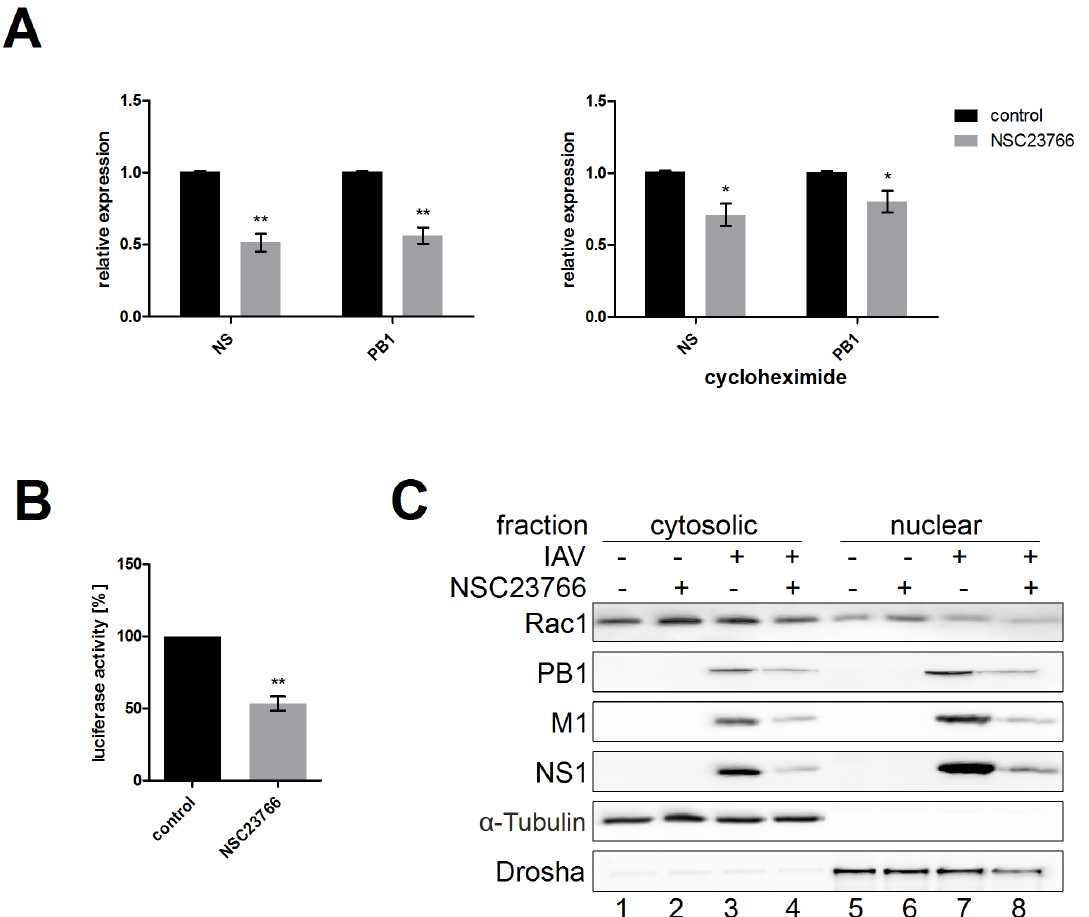
Figure 5. NSC23766 treatment results in reduced viral mRNA levels caused by impaired activity of the viral polymerase complex. (A) A549 cells were infected with A/Puerto-Rico/8/34 rec. (moi=5) and subsequently treated with NSC23766 (100 m M) 30 min post-infection. Six hours p.i., the RNA was isolated for qRT-PCR and the fold increase of ns and pb1 mRNA compared to uninfected cells was determined using the housekeeping gene gapdh as the internal standard. Treatment of cells with cycloheximide (10 m g/ml, right panel) was performed to inhibit de novo protein synthesis. (B) Viral polymerase activity was assayed in a mini-genome system using a luciferase reporter gene driven by the viral RNA promoter. A549 cells were transfected with plasmids encoding PB1, PB2, PA, and NP in addition to the luciferase reporter plasmid. Six hours post- transfection, NSC23766 was added at a final concentration of 100 m M and cells were incubated for a further 24 h. Luciferase activity was assayed in cell lysates. Data represent means 6 SD of three independent experiments including three biological samples. Statistical significance was evaluated with Student’s t -test (* p , 0.05; ** p , 0.01). (C) A549 cells were infected with A/Puerto Rico/8/34 rec. (moi=0.01) for 30 min and were subsequently treated with NSC23766 (100 m M). After eight hours of infection nuclear extracts were prepared and subjected to Western blot analysis. The amounts of Rac1 and the viral proteins PB1, M1, and NS1 were analyzed in cytosolic and nuclear fractions. Detection of the cytosolic protein a -Tubulin and the nuclear localized protein Drosha served as control for efficient